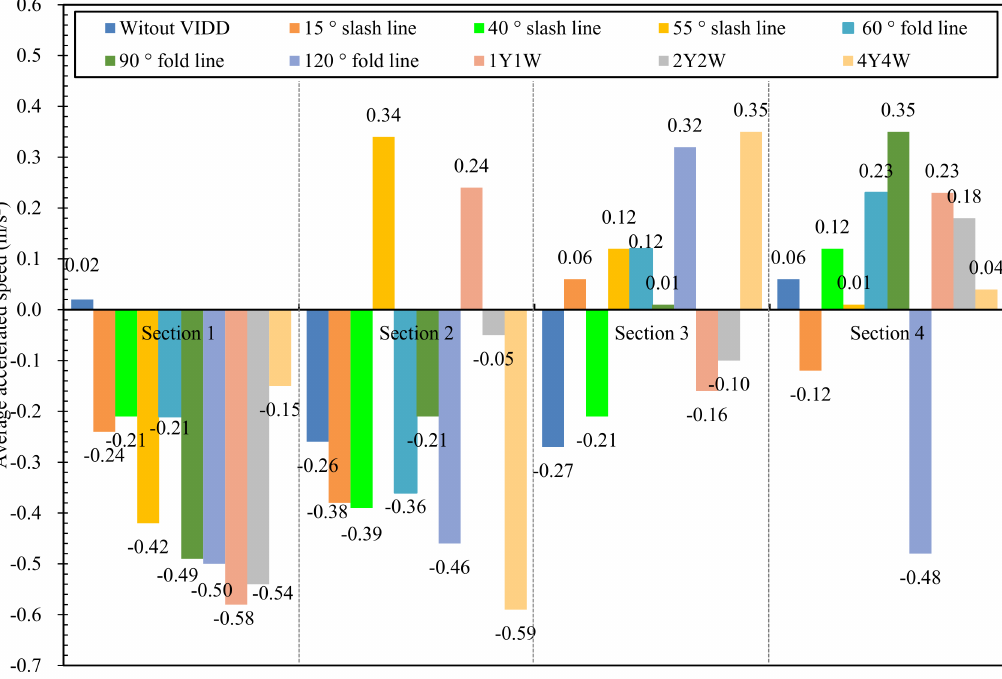
Figure 18. Average acceleration of vehicles in middle of tunnel with and without